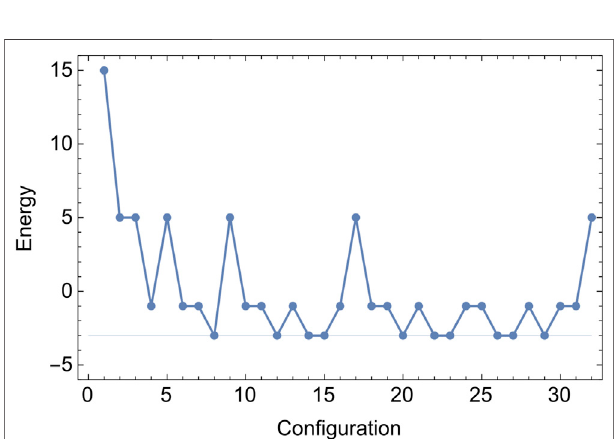
FIGURE 10 | Energy landscape of the pentagram spin network with N (cid:2) 5and c (cid:2) − 1.Thegroundstatecon fi gurationssatisfytheprototypescalar constraint (13) and span physical phase space Γ phys of the